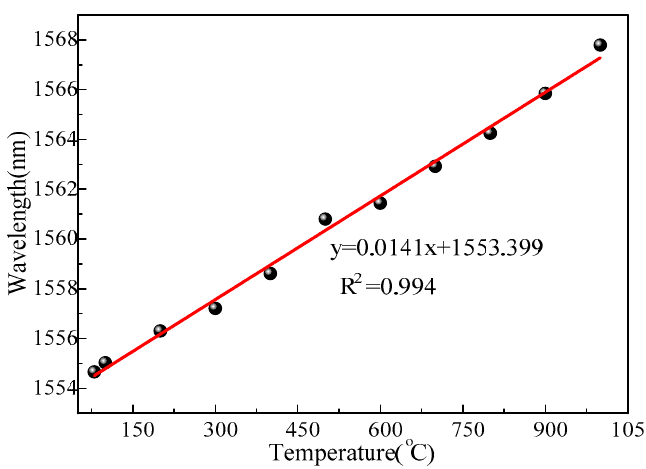
Figure 8. Temperature fitting curve.